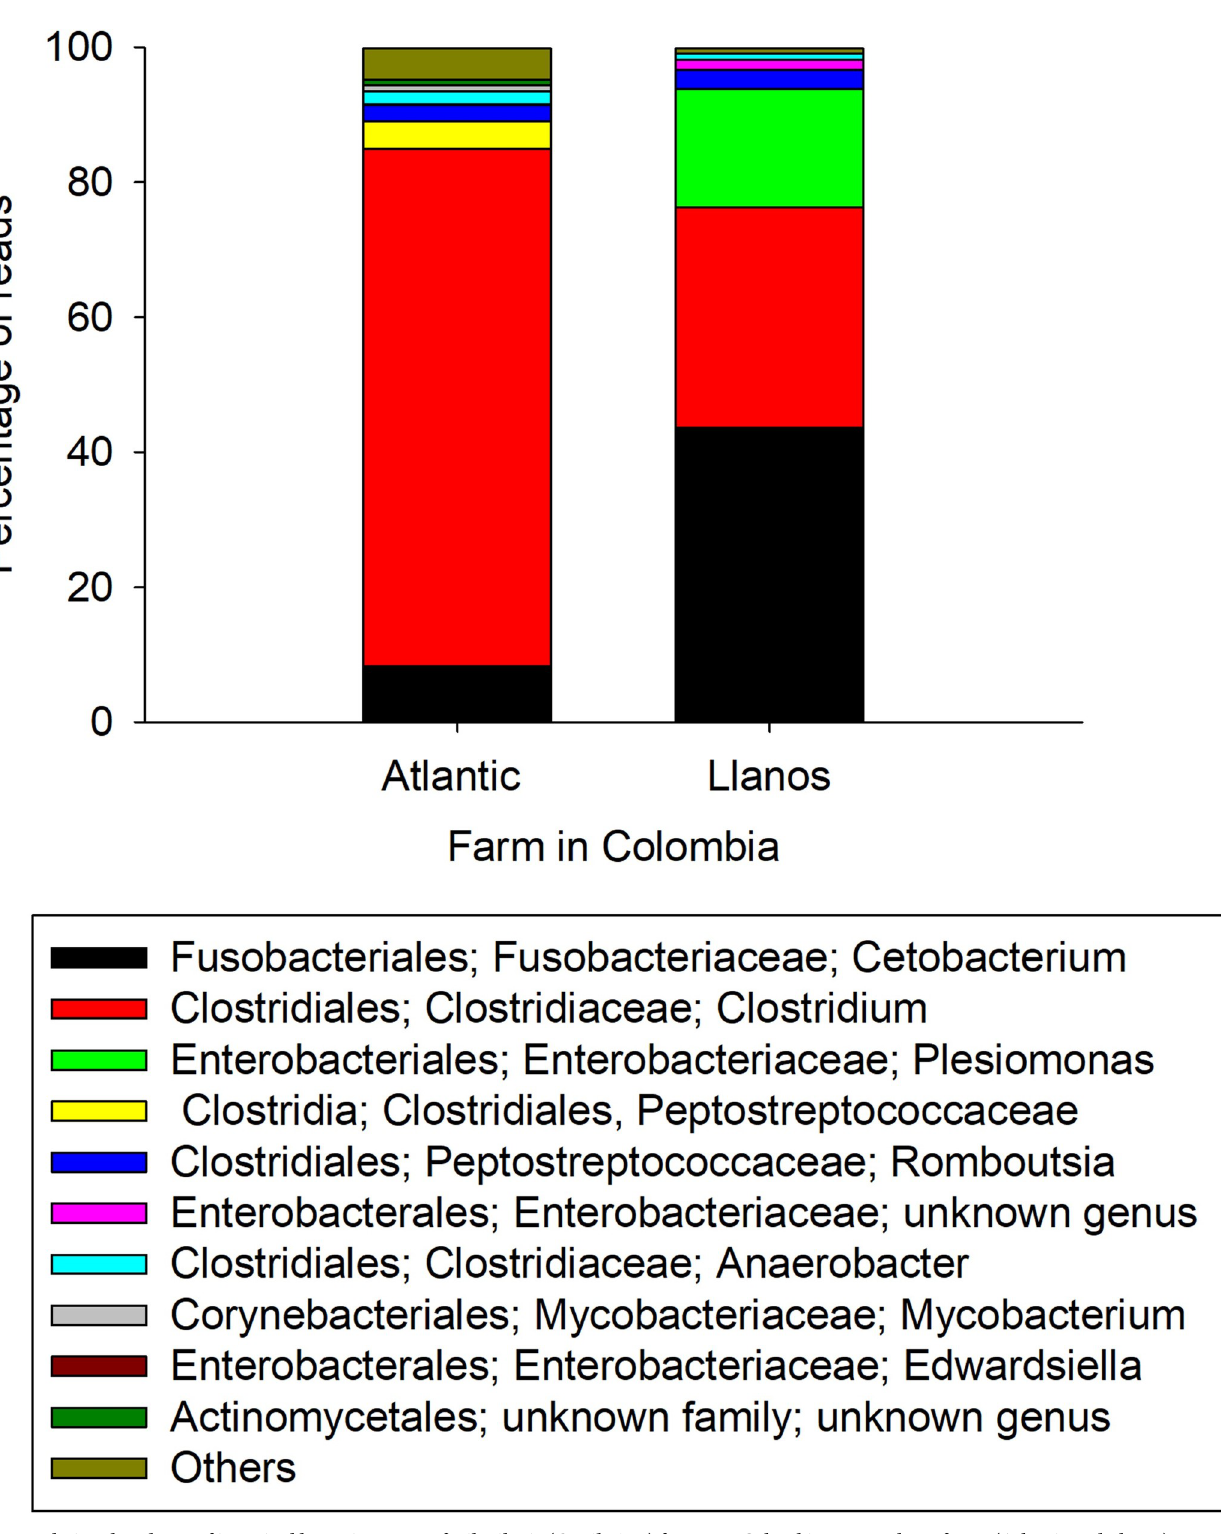
PLOS ONE | https://doi.org/10.1371/journal.pone.0215375 May 3,